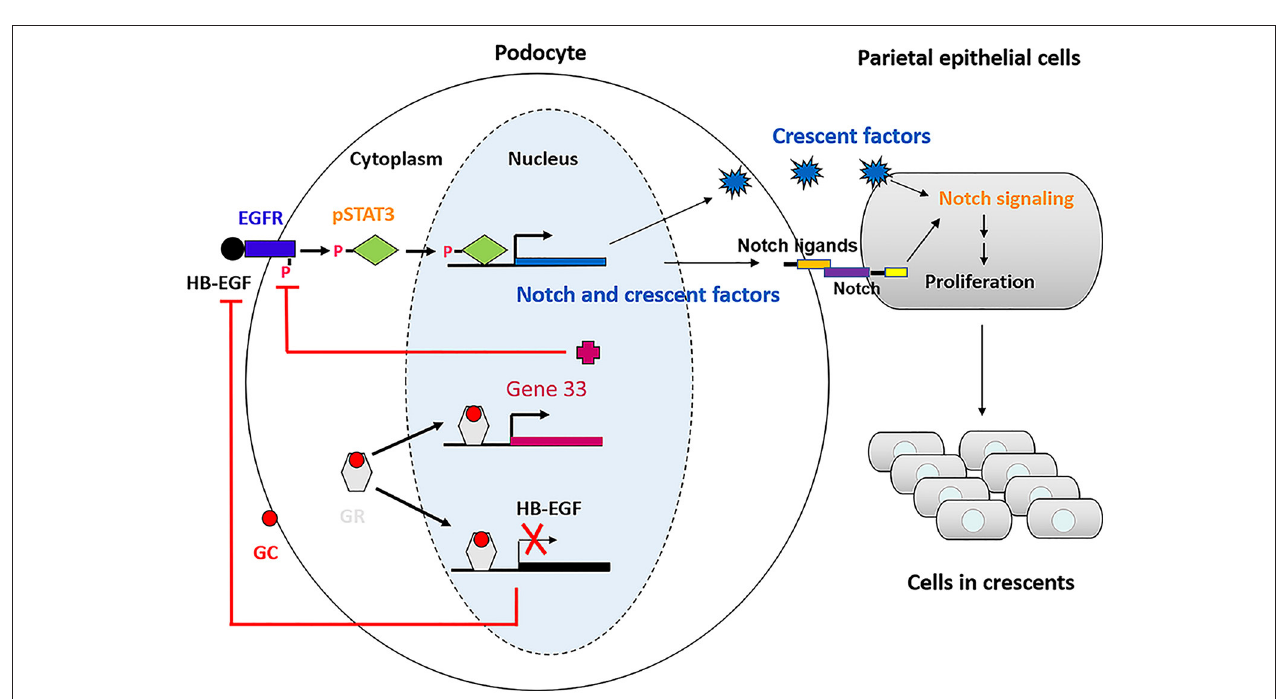
FIGURE 9 | Schematic of the mechanism underlying glucocorticoids effectiveness on anti-GBM crescentic